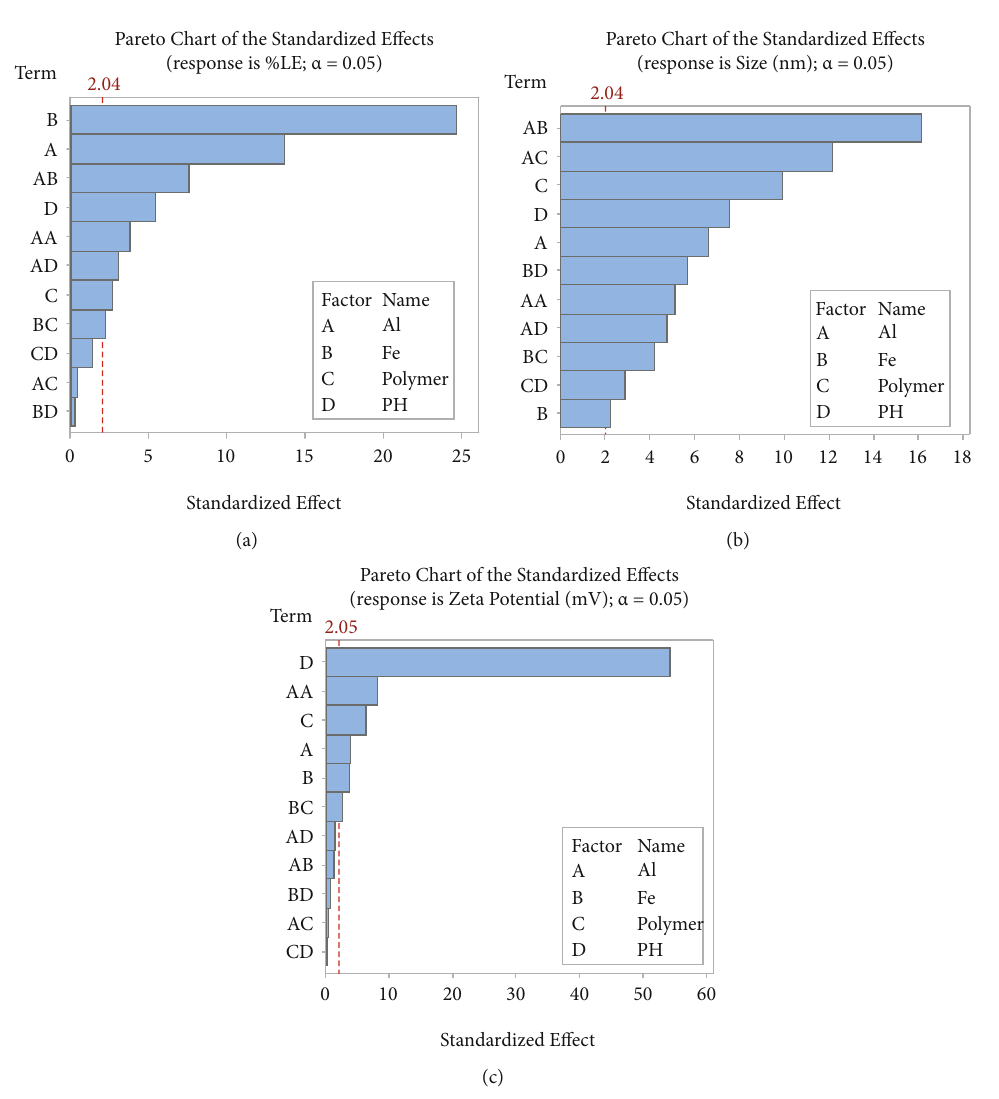
Figure 1: (a) Pareto charts showing the impact for %LE, (b) particle size, and (c) zeta